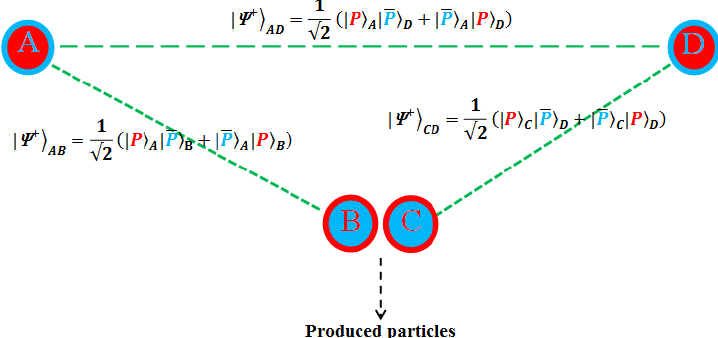
Fig. 3. Schematic diagram for the entanglement transfer from the packaged entangled states j (cid:3) þ i AB ¼ 1 ffiffi ðj P i A j (cid:1) P i B þ j (cid:1) P i A j P i B Þ and j (cid:3) þ i CD ¼ 1 ffiffi 2 p